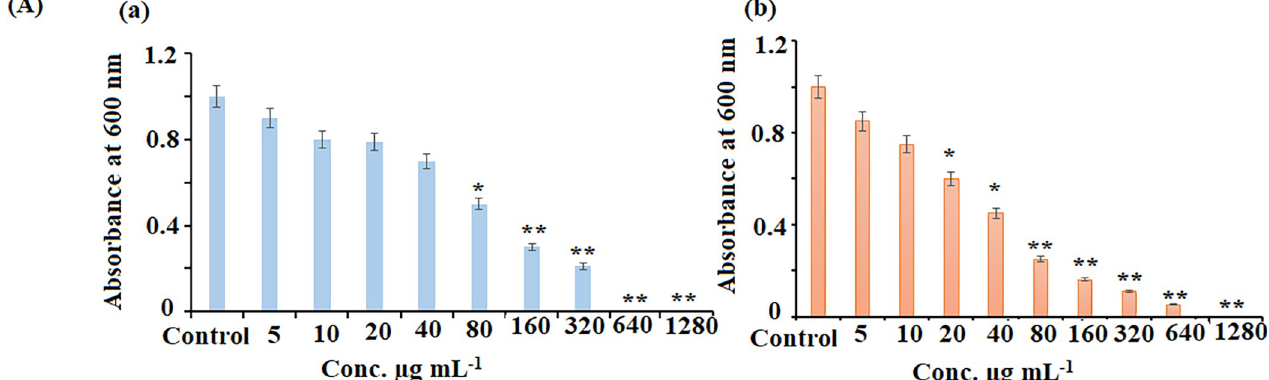
Fig 7. Minimum inhibitory concentrations (MIC) of sunflower oil/FA–CSNPs bionanocomposite ( μ g mL –1 ) against (a) B . subtilis and (b) P . aeruginosa . The data represented as mean ± standard deviation of thrice measurements.